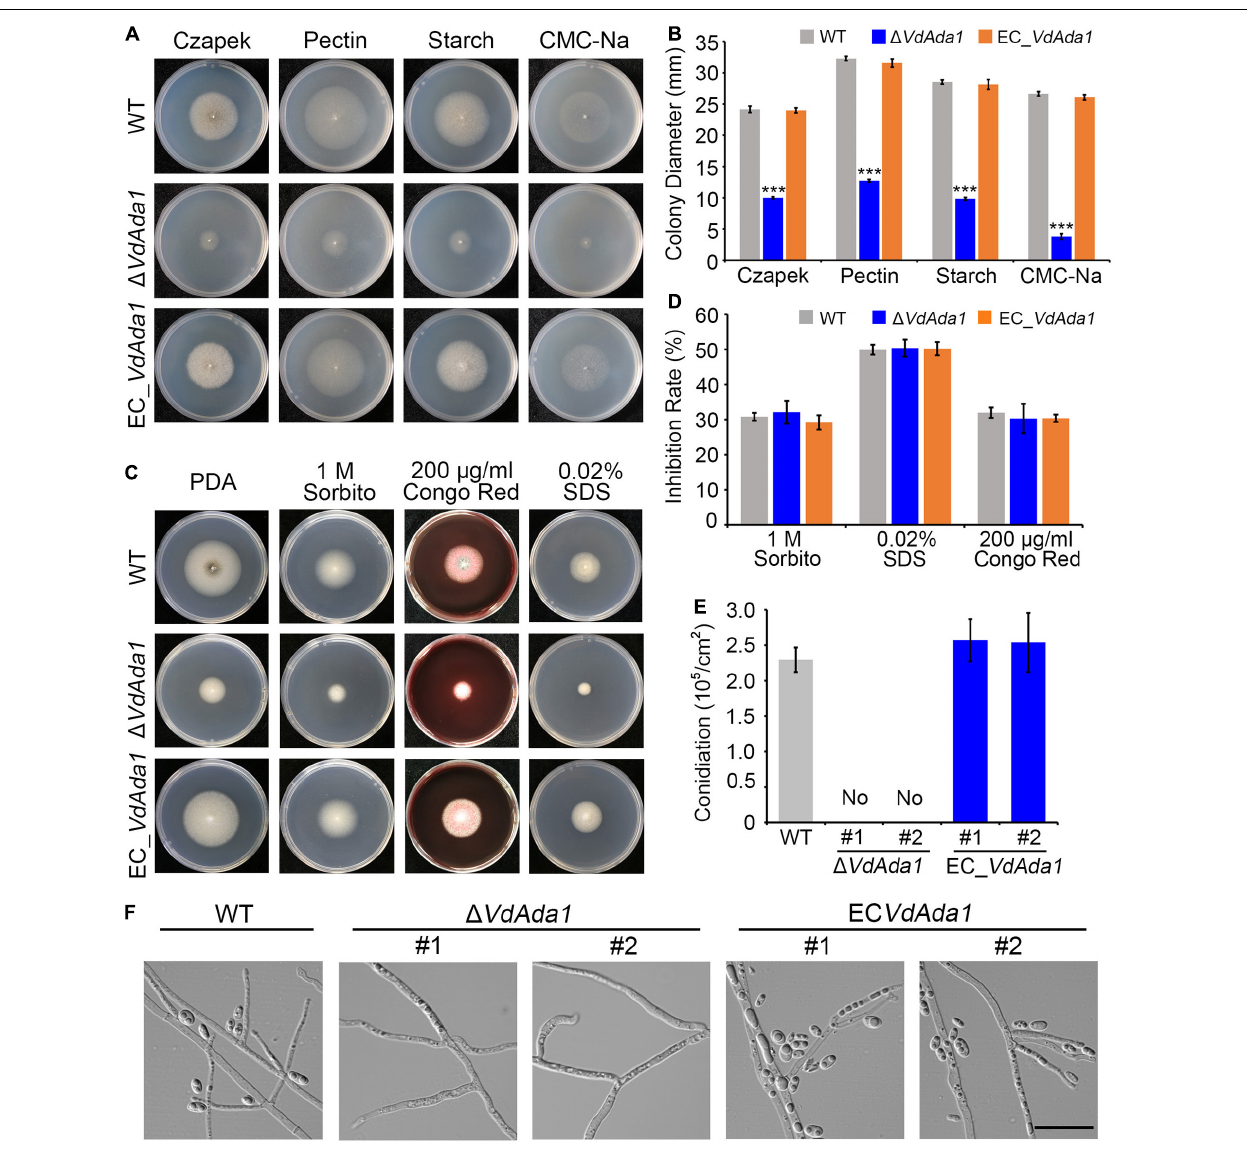
FIGURE 2 | VdAda1 in Verticillium dahliae is necessary for conidia production and normal growth rate, but not for cell wall integrity and osmotic stress responses. (A) Colony morphology of the wild type strain, (cid:49) VdAda1 , and EC_ VdAda1 strains on Czapek medium containing different four carbon sources. (B) Colony diameter (mm) of each strain grown on different medium. Values shown are the average of three colony diameters. Error bars represent the standard deviation calculated from three replicate experiments, and a triple asterisk indicates significant differences ( P < 0.001) in colony diameter of (cid:49) VdAda1 compared with the wild type using one-way analysis of variance (ANOVA). (C) Colony appearances of the wild type, (cid:49) VdAda1 , and EC_ VdAda1 strains cultured on Czapek medium containing 1 M sorbitol, 200 µ g/ml Congo red, and 0.02% SDS at 25 ◦ C for 7 days. (D) Sensitivity of the wild type, (cid:49) VdAda1 , and EC_ VdAda1 strains to different cell wall stress chemicals. Values shown are the average from three repeated experiments and the data were analyzed using one-way analysis of variance (ANOVA). Error bars represent the standard deviation of three replicate experiments. (E) Quantification of conidial production. After the strains were grown on Czapek medium for 7 days, three 7 mm-diameter plugs of the fungal colony were collected by a hole puncher and shaken in 3 mL of sterile water, and the number of conidia were counted by a hemocytometer. The #1 and #2 indicate two independent deletion mutants or complemented transformants. Values shown are the average from three repeated experiments and the data were analyzed using one-way analysis of variance (ANOVA). Error bars represent the standard deviation calculated from three replicate experiments. (F) Observations of hyphae and production of conidia by the wild type, (cid:49) VdAda1 , and EC_ VdAda1 strains grown on hydrophobic cover slips for 5 days using a differential interference contrast microscope. Scale bar = 20 µ m.